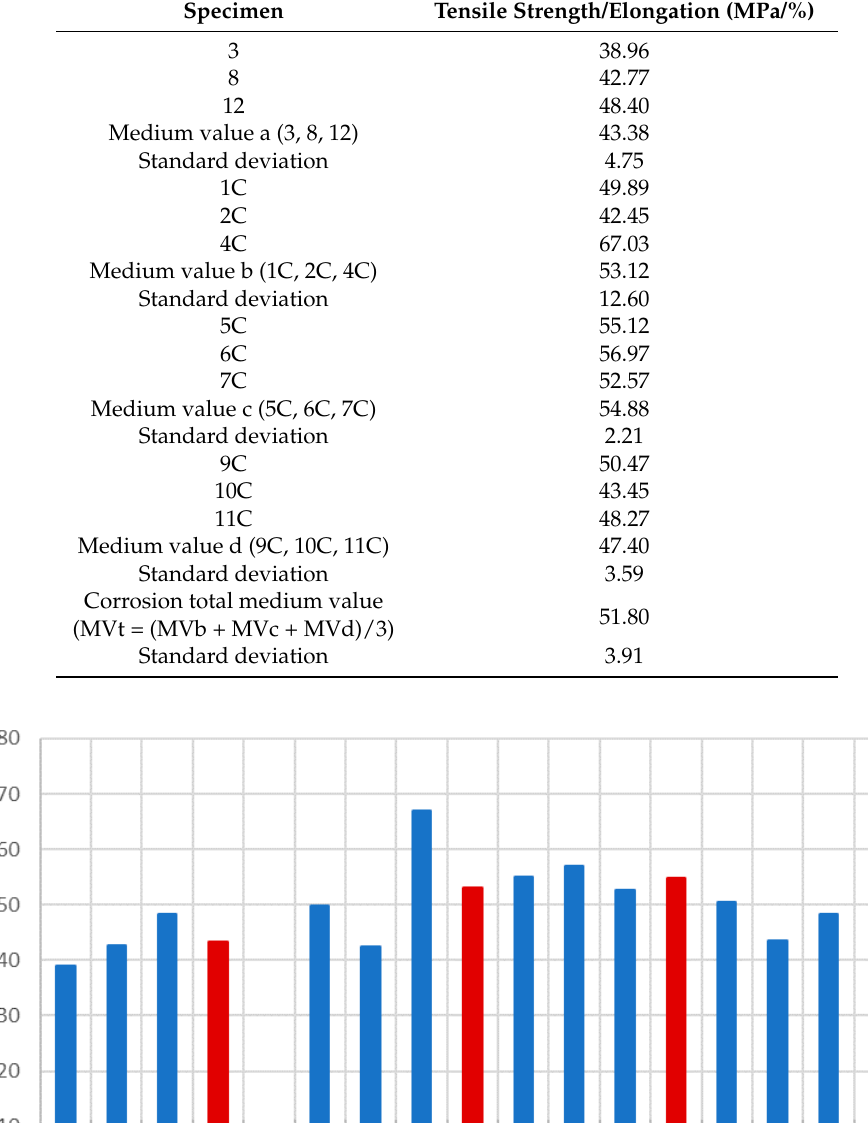
Table 7. Tensile strength/elongation relation values per specimen and medium values.